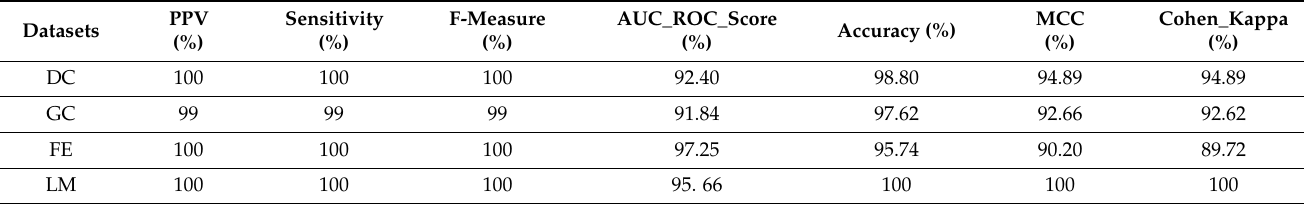
Table 8. Results of Gradient boosting algorithm.